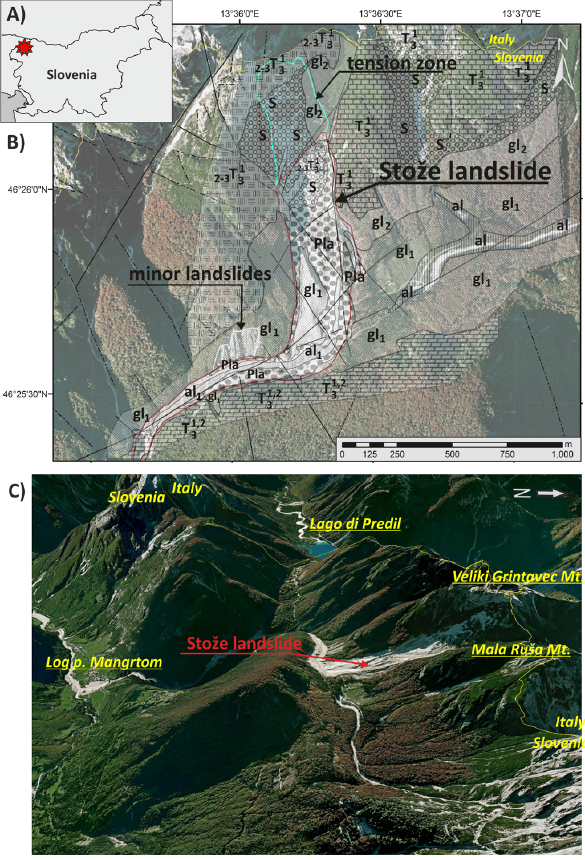
Fig. 1. Stože landslide: (A) location of the test site, (B) general settings of the site with geology modified after Petrica and Špaca- pan (2001) and Jurkovšek (1987) and mapped faults (full black lines) and with faults interpreted from topography (dot-and-dashed black lines) and (C) perspective view of the Google Earth or- thophoto from E. Legend of the geological map: al1 – boulders, blocks and scree as remains of the landslide, loose; below 0.5m clayey scree, clay, wood; Pla – the remains of the landslide: mixed clay, scree, sandy soil with blocks; potential mass for new LS; s – slope scree, blocks of dolomite; al – aluvial gravel and scree, perme- able; gl2 – the remains of the morraine: clayey-silty soil with lime- stone scree and bigger blocks; low permeable; gl1 – mixed silty- sandy to gravel-scree soil (=low cemented morraine), low perme- ability; T 1 , 2 – main dolomite; layers 0.2–1m with marl layers, near 3 the fault the dolomite is highly fractured; 2 + 3 T 1 – dark grey marly 3 limestone, marly dolomite, marl, claystone; T 1 – massive and thick 3 bedded